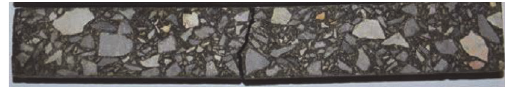
Figure 4: Failure sample from laboratory bending beam test.